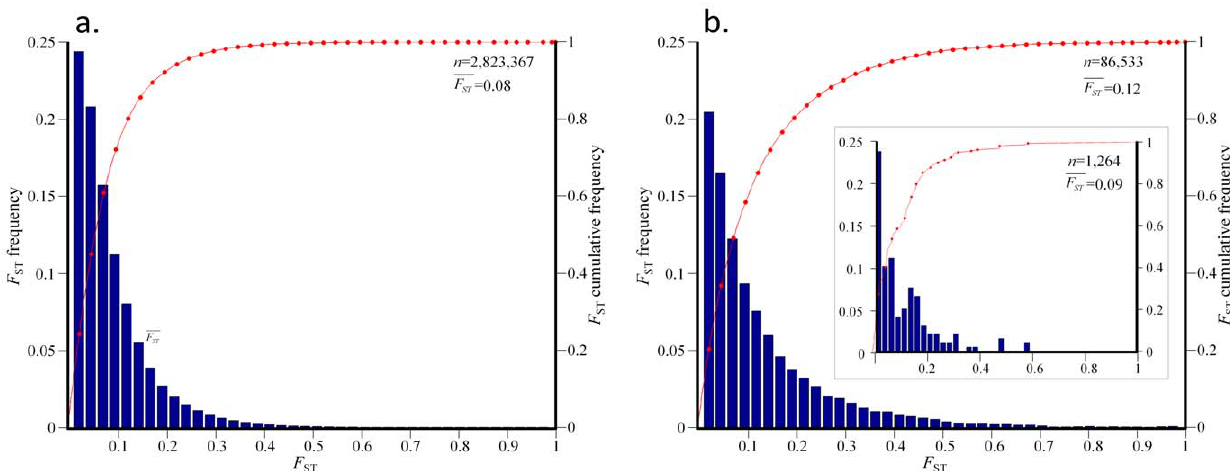
Figure 4. Distribution of locus-specific F ST in three continental populations (CEU + TSI, CHB + CHD + JPT, LWK + MKK + YRI). F ST values were obtained for (a) 2,823,367 autosomal SNPs and (b) 86,533 SNPs on the non-recombining region of the X chromosome and 1,264 SNPs on the PAR region (inset). The histograms show bin distribution as indicated on the x-axis and the cumulative distribution (line).